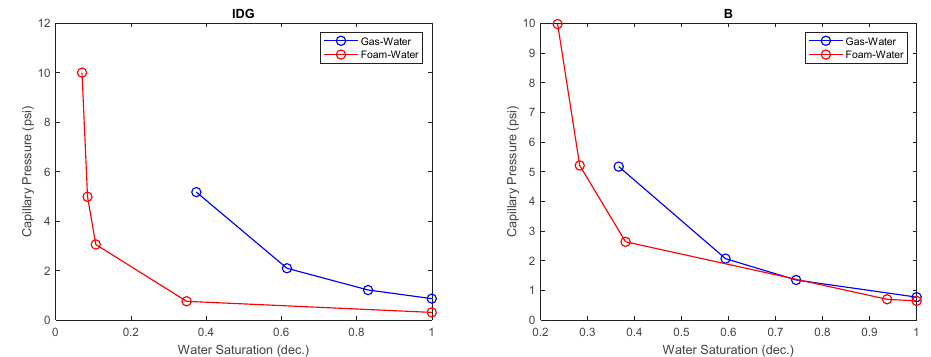
Figure 10. Comparison of the capillary pressure curves for foam–water and gas–water in di ff erent rock samples.